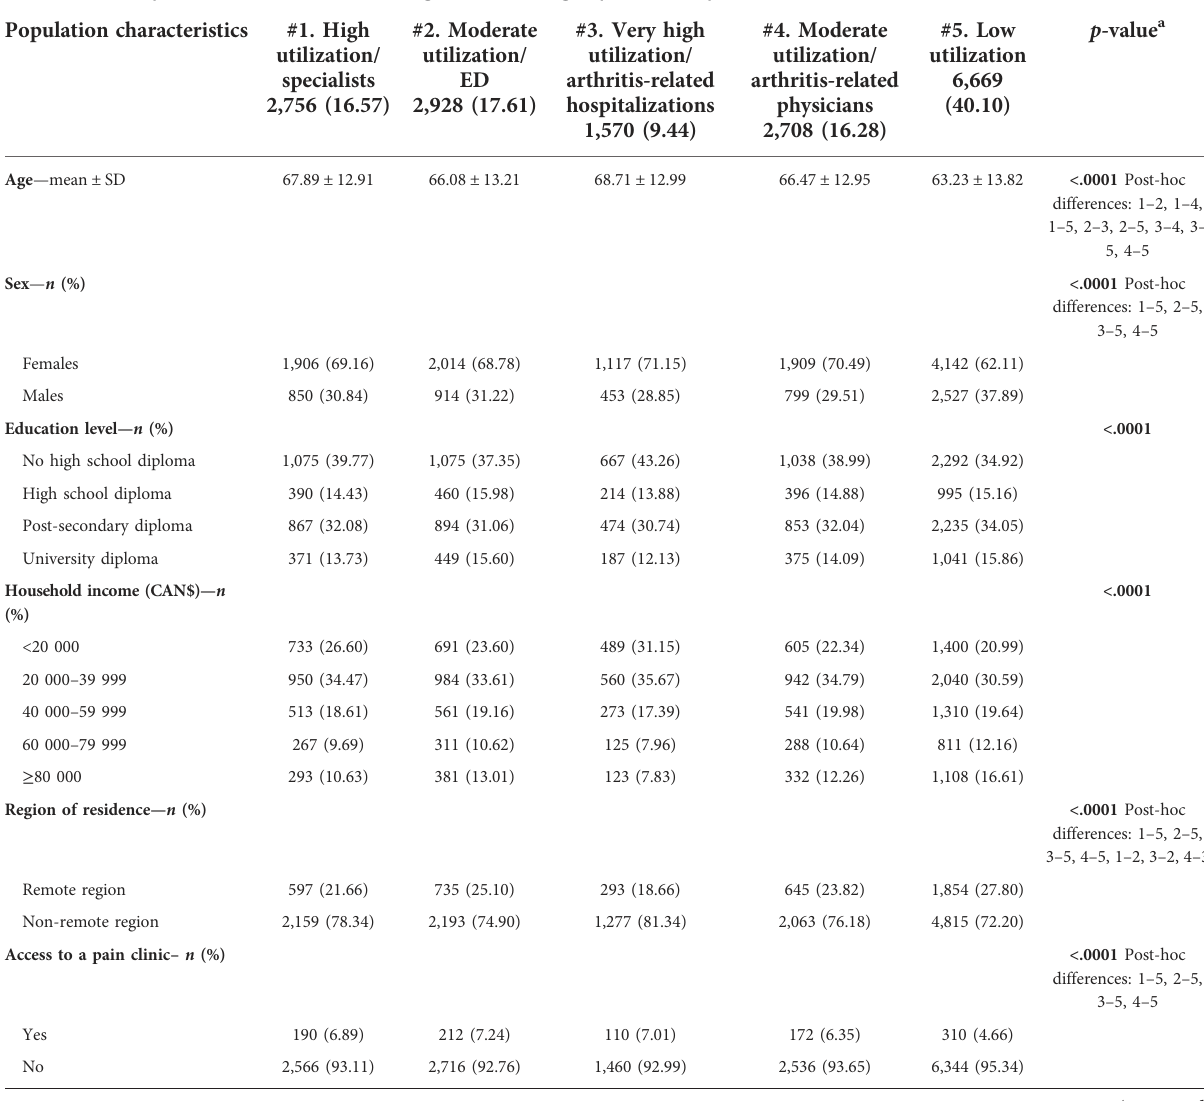
TABLE 3 Arthritis patients ’ characteristics according to their CareT group membership. Population